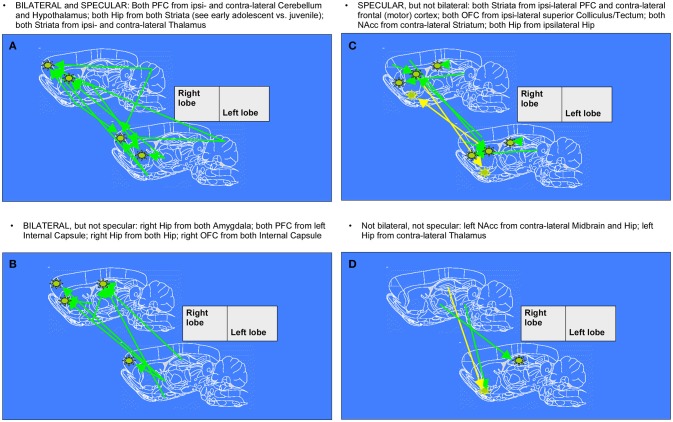
Diagrams denoting increased connections between “early” and “late” age stages in rat brain (adolescent transition). The meaning of the arrows is the same as in Figure 5. (A,C) specular changes (B,D) not specular changes (A,B) bilateral changes (C,D) not bilateral changes. The “specular” situation is that in which a same-seed to same-region connection emerges as mirrored (i.e., fully corresponding pixels, but on the other hemisphere) when a seed is placed both on left lobe and on right lobe (see A,C). The “bilateral” situation is that in which, when seeds are placed on both sides of area A, a connection coming not from the “mirror” but from the “very same” region (i.e., identical or neighboring pixels) emerges, thus appearing first ipsi-laterally and then contra-laterally (see A,B).